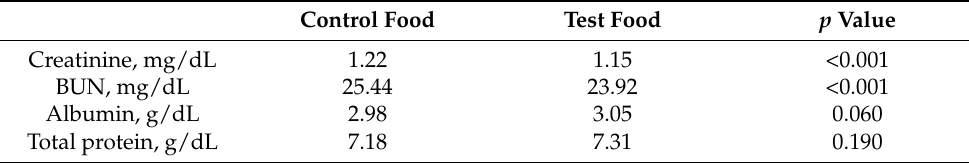
Table 4. Blood chemistry parameters.